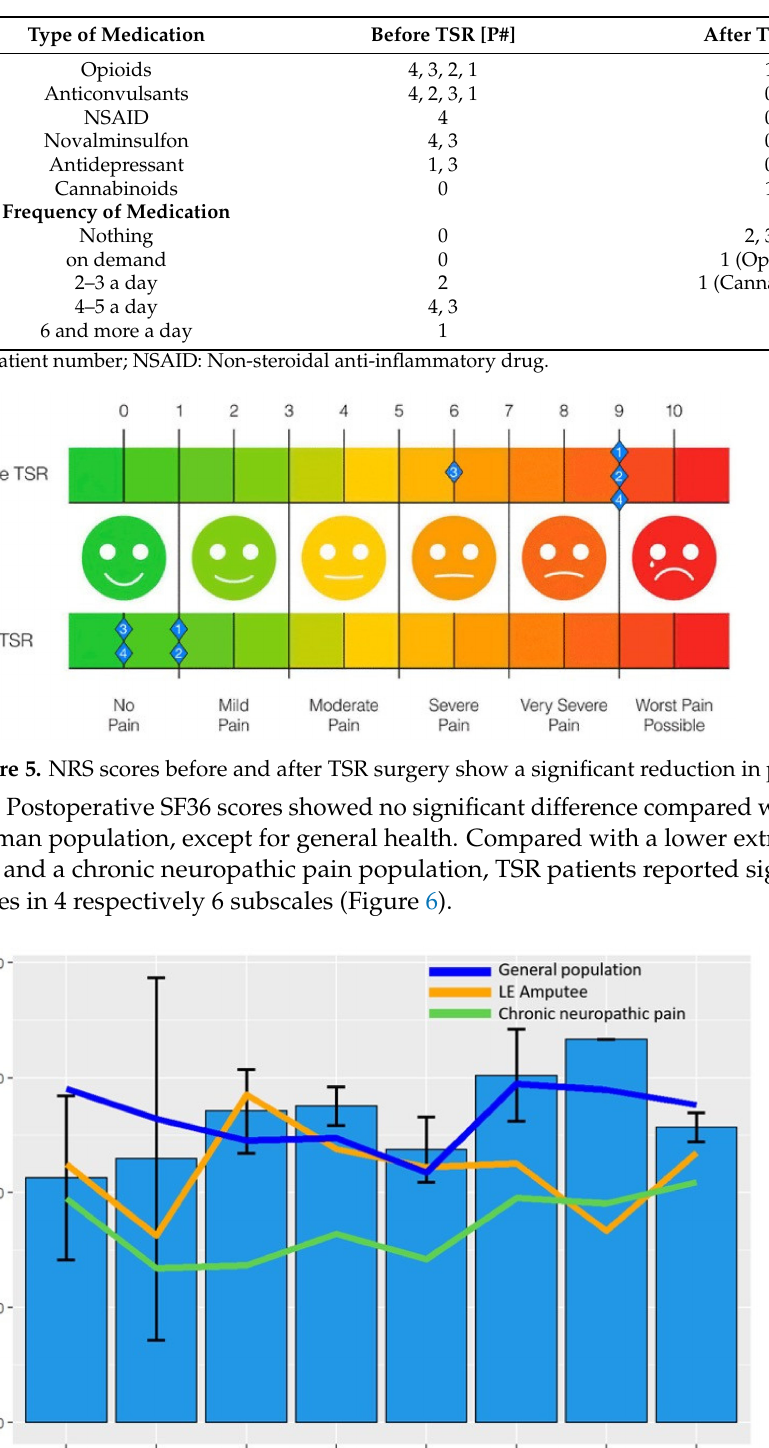
Table 3. Pain medication before and after TSR.